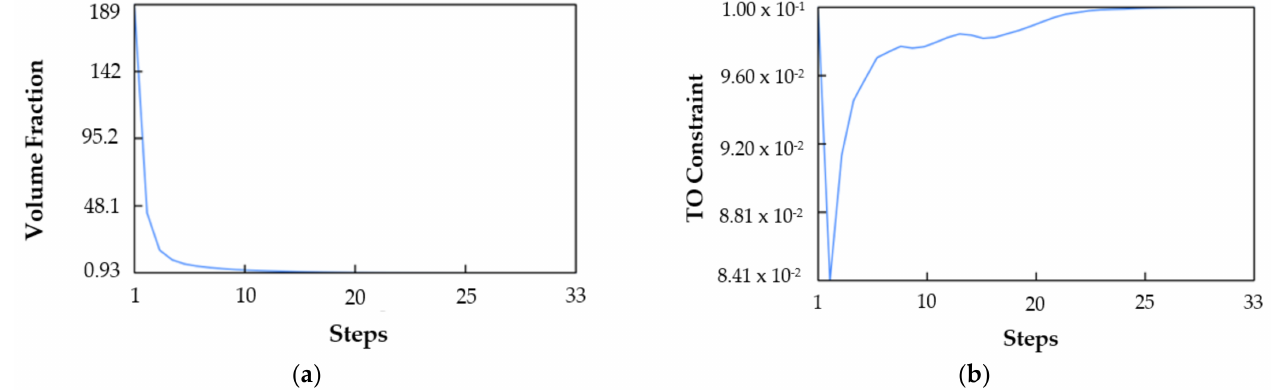
Figure 6. ( a ) Volume fraction per each step ( b ), and volume fraction constraints on each iteration step of ‘structure